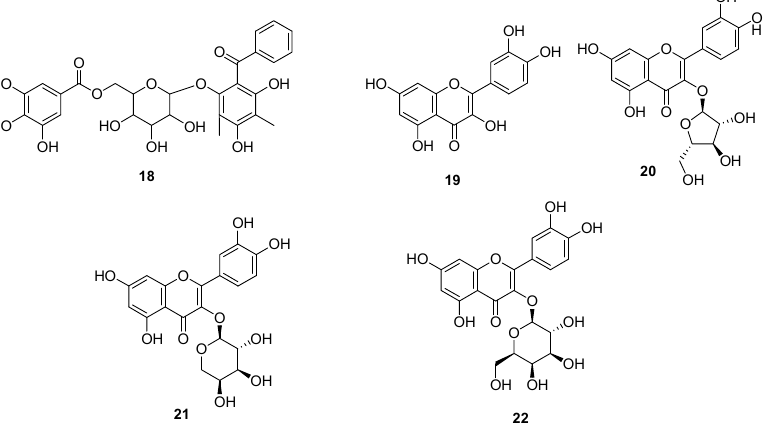
Figure 3. Benzophenone galloyl glycoside ( 18 ) and flavonoids ( 19–22 ) were isolated from the leaves of the P. guajava L.